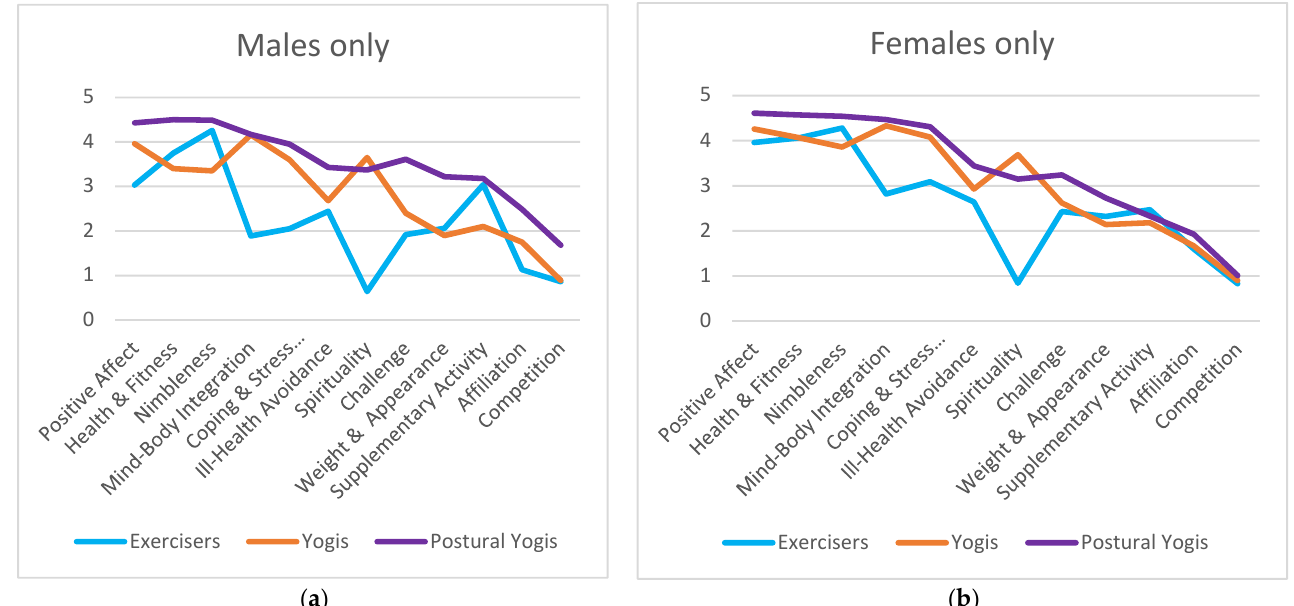
Figure 2. Mean scores on participation motives per participant subgroup, for ( a ) males only and ( b ) females only.